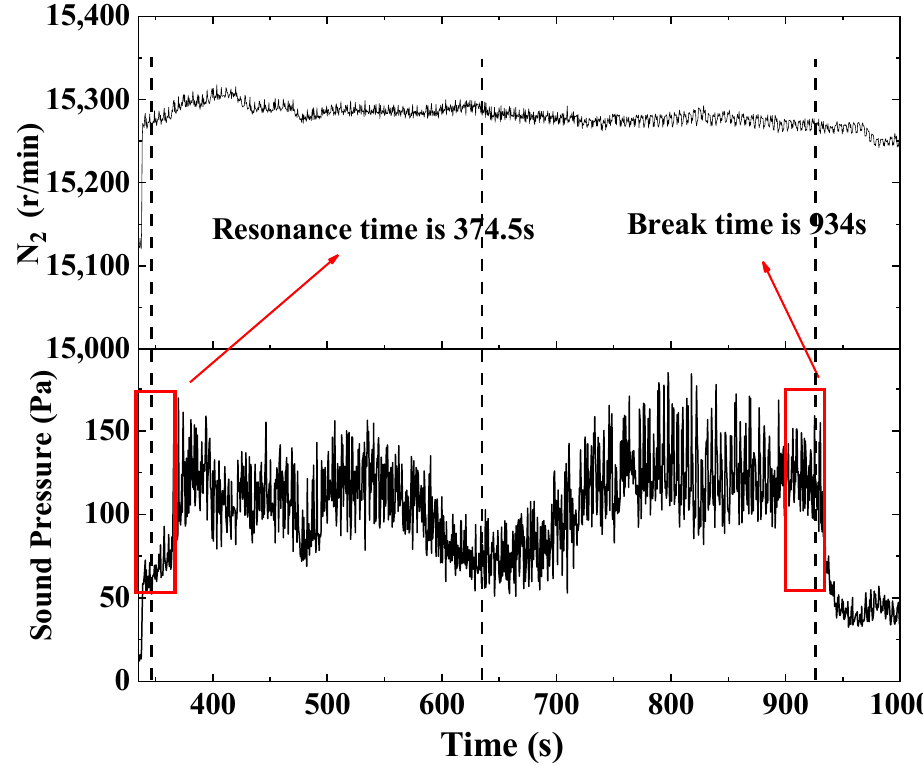
Figure 7. Time-speed-sound pressure diagram of prefabricated gear fracture process.